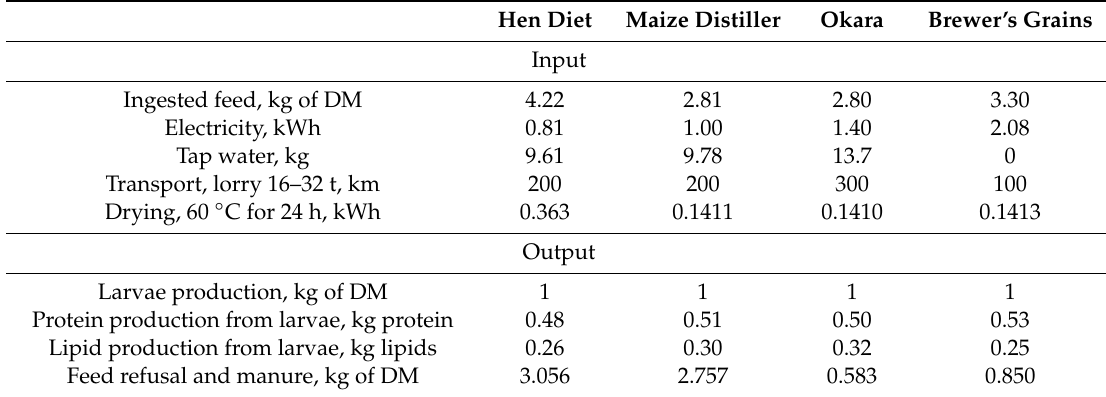
Table 1. Main items of life cycle inventory for the larvae production (1 kg dry matter (DM)). Hen Diet Maize Distiller Okara Brewer’s Grains Input Ingested feed, kg of